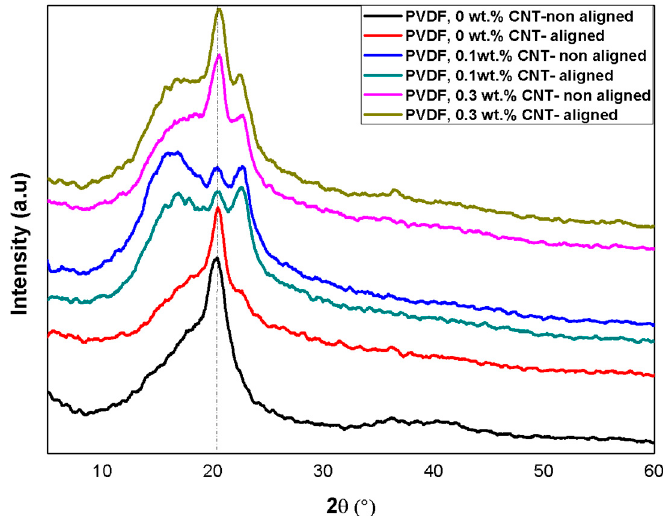
Figure 8. XRD analysis for aligned and non-aligned PVDF nanofiber.